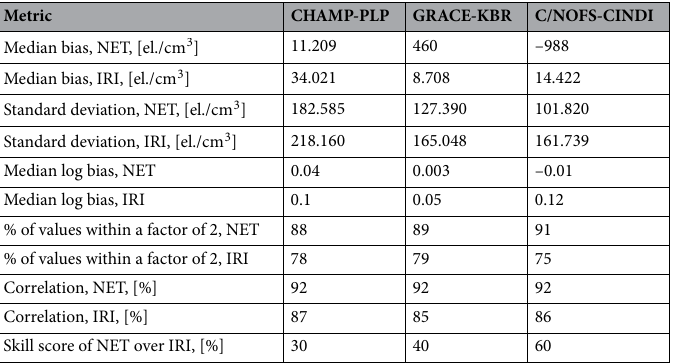
Table 1. Metrics for comparisons between NET and IRI models and observations on 3 independent